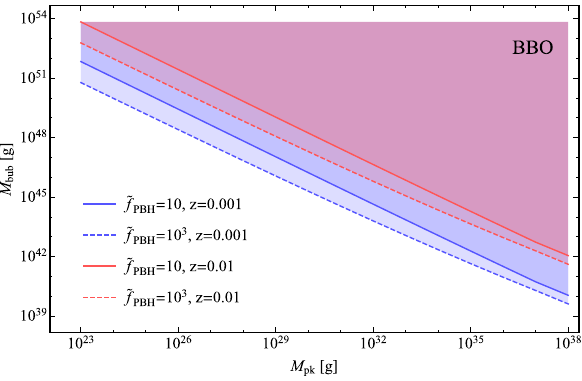
Fig. 7 TheparameterspaceofthebubblemassandpeakmassofaPBH bubblethatcanbeprobedbyBBOat0 . 1Hzwith (cid:2) GW h 2 = 2 . 9 × 10 − 15 . The solid and dashed lines denote ˜ f PBH = 10 , 10 3 , respectively. Blue and red shaded regions denote z = 0 . 001, 0 . 01,